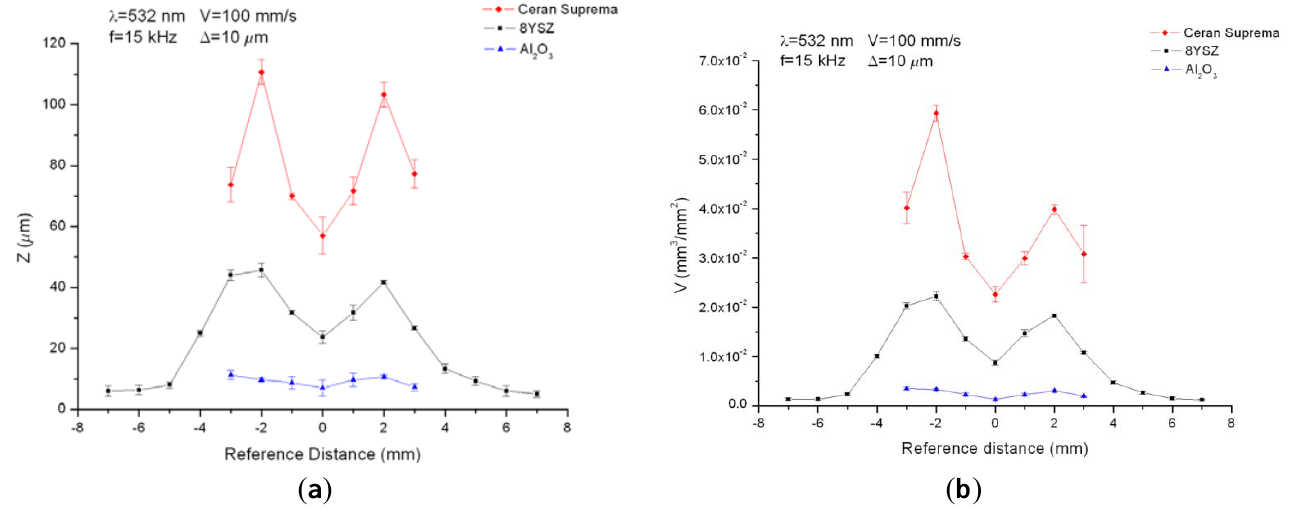
Figure 7. Machined depth ( a ) and removed volume ( b ) for 8YSZ, Al substrates processed at 532 nm using a working frequency of 15 kHz, a scanning speed of 100 mm/s and a distance between adjacent lines of 10 μ